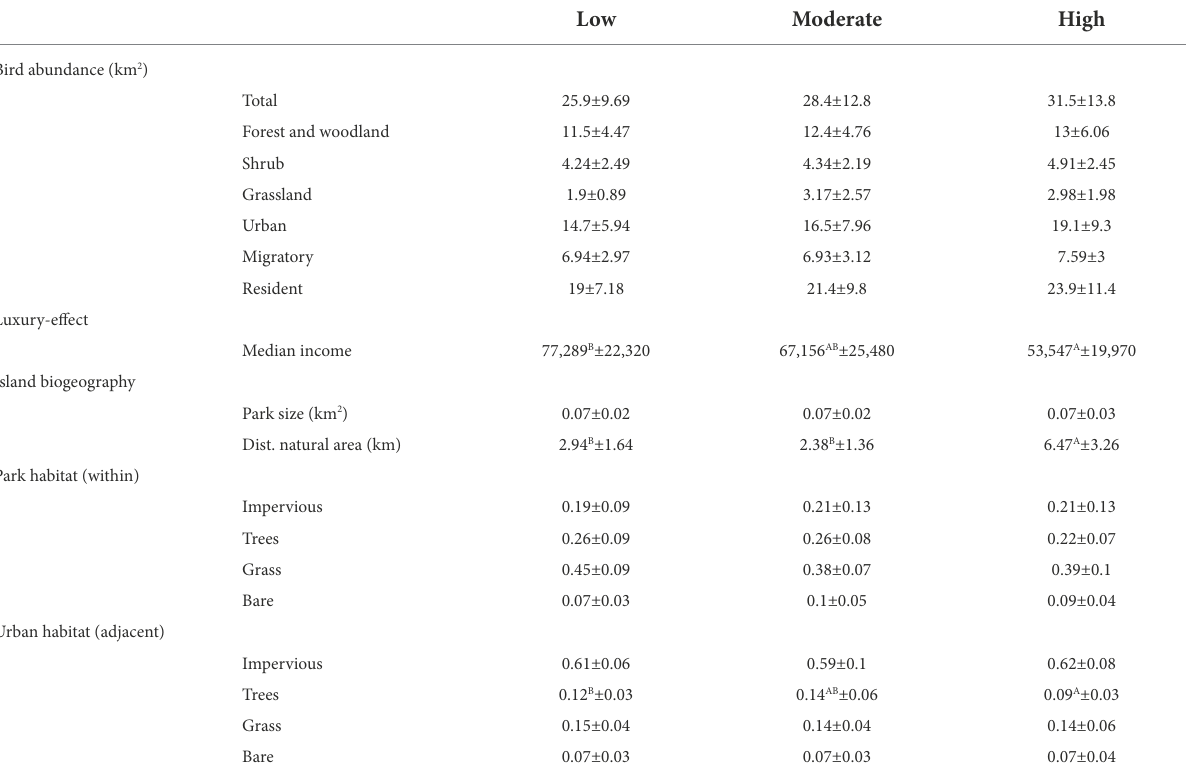
TABLE 2 Mean ± S.E. summaries of the total abundance of birds, and six additional groups indicating combinations of bird species associated with forest, shrub, grassland, or urban ecosystems during the breeding period, or whether species are wintering migratory birds (migratory) or resident to the L.A. study